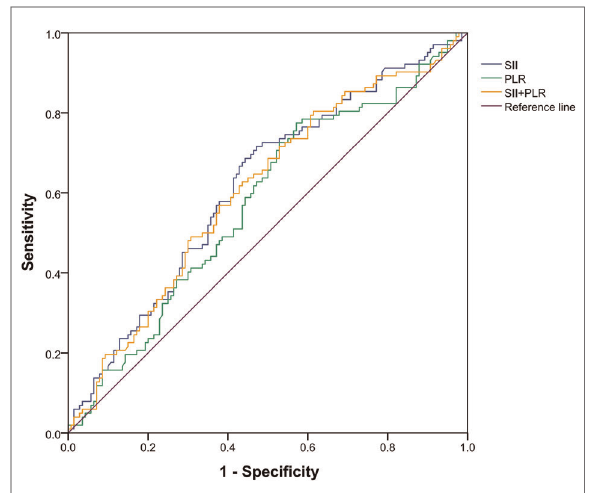
FIGURE 4 Receiver operating characteristic curve of a systemic immune in fl ammation index (SII), platelet-to-lymphocyte count (PLR), and SII and PLR combined. The area under the curve for SII, PLR, and both was 0.617 ( p =0.002), 0.575 ( p =0.025), and 0.606 ( p = 0.005),